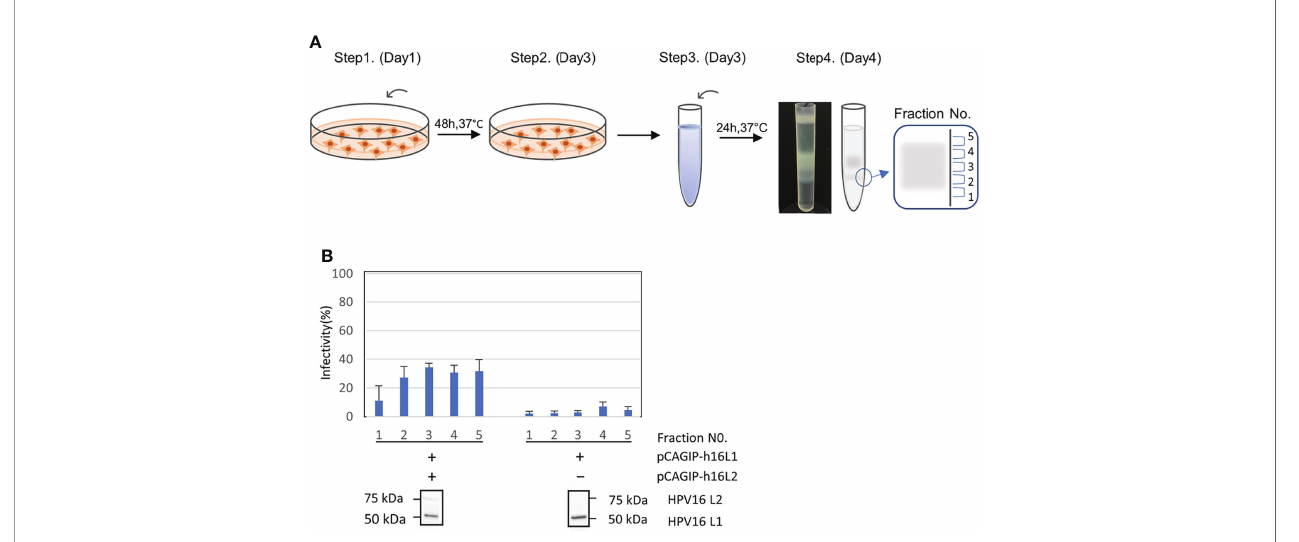
FIGURE 1 | Production, infectivity and western blotting assay of HPV-PsV-GFP-TK. (A) Step 1: Co-transfection of 293FT cells with HPV L1/L2 and a reporter plasmid. Step 2: Cells are harvest two days after transfection. Step 3: Cell pellets are resuspended in DPBS with 9.5 mM MgCl 2 , Brij58, RNase Mix and 1M (NH 4 ) 2 SO 4 . Step 4: Cell pellet wash followed by supernatant ultracentrifugation at 281,000 × g for 4.5 h at 16°C, and fraction collection (No.1 to 5). (B) The infectivity of PsVs using the reporter plasmid with pCAGIP-h16L1 and pCAGIP-h16L2 (left) and with only pCAGIP-h16L1 (right) analyzed in triplicate. Infectivity is indicated by the proportion of fl uorescent cells as measured using fl ow cytometry. Western blotting of HPV16 L1 and HPV16 L2 in HPV PsV. PsV using pCAGIP-h16L1 without pCAGIP-h16L2 is used as a negative control in HPV16